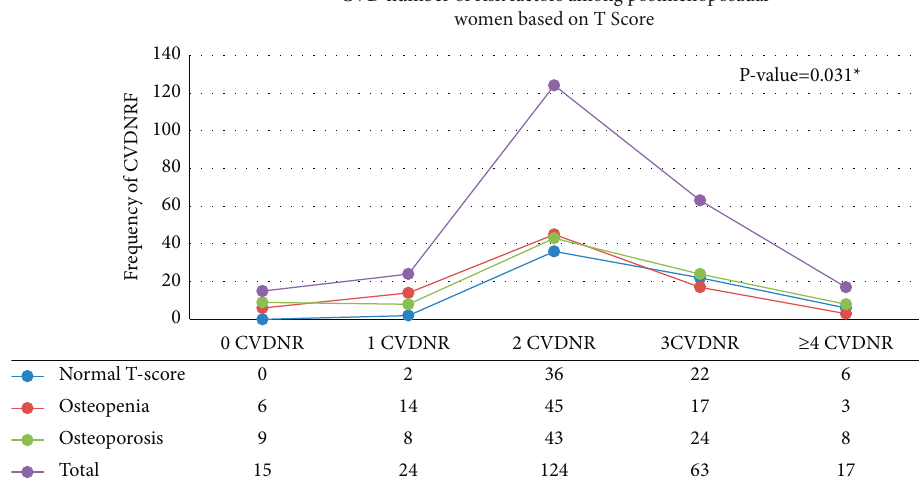
Figure 1: Cardiovascular disease number of risk factors (CVDNRF) among normal T -score, osteopenic, and osteoporotic postmenopausal women. ∗ P value was obtained using the chi-square test. CVD risk factors included are as follows: body weight > 25kg/m 2 , waist ci. Table 3: Multiple linear regression with the diagnosis ∗ being the dependent variable.